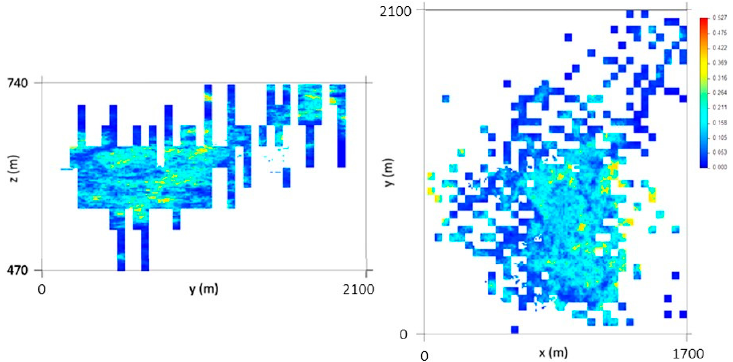
Figure 5. Direct sequential simulation (DSS) first-phase results: Px81 (left) and Pz75 (right). The diagrams show one of 1000 scenarios.